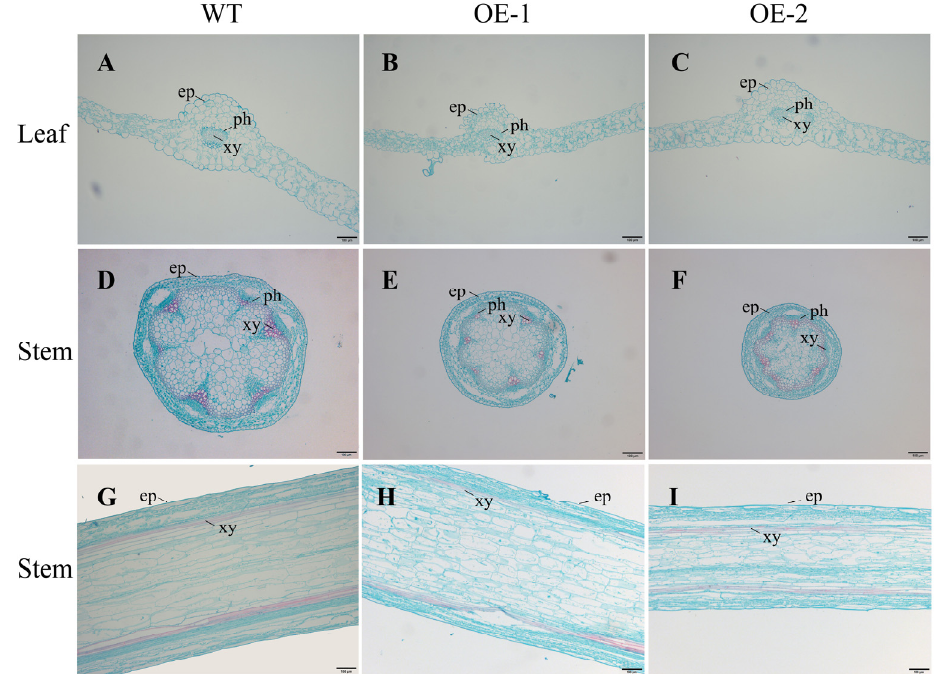
Figure 11. Histochemical staining sections of leaves and stems from WT and transgenic Arabidopsis plants hosting CsLBD39 gene under KCl treatment. ( A – C ) Histochemical staining of leaves from WT and transgenic Arabidopsis plants hosting CsLBD39 gene. ( D – F ) Histochemical staining of stem cross sections from WT and transgenic Arabidopsis plants hosting CsLBD39 gene. ( G – I ) Histochemical staining of stem longitudinal sections from WT and transgenic Arabidopsis plants hosting CsLBD39 gene. ep, epidermis; ph, phloem; xy, xylem. Scale bar = 100 μ m.